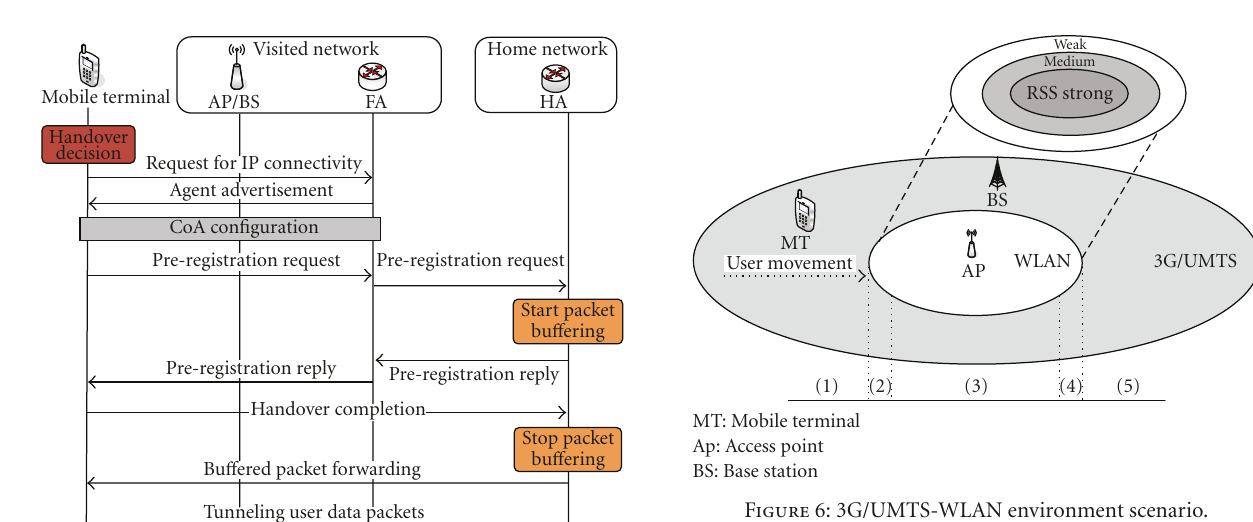
Figure 6: 3G/UMTS-WLAN environment